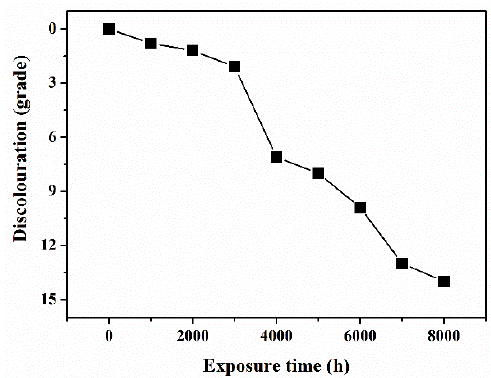
Figure 11. Coating discoloration after the QUV test.